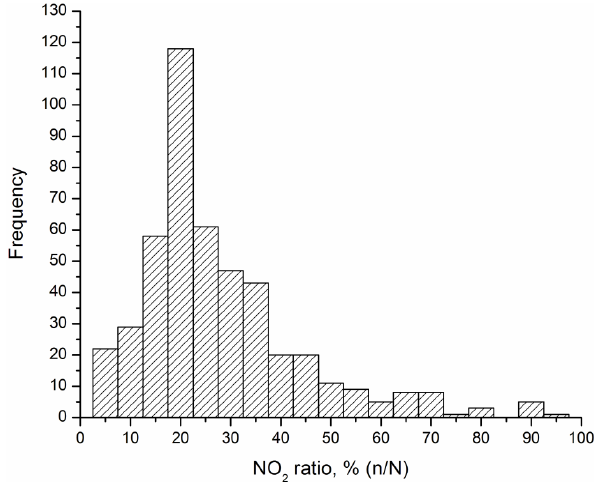
Fig. 17. Distribution of the NO 2 /NO x molar ratio among the studied Figure 17. Distribution of the NO 2 /NO X molar ratio among the studied ships. The total 1049 ships. The total molar ratio range was divided into 19 bins. Frequen- molar ratio range was divided into 19 bins. Frequencies of the bins are plotted along 1050 cies of the bins are plotted along the y-axes. the y-axes. 1051